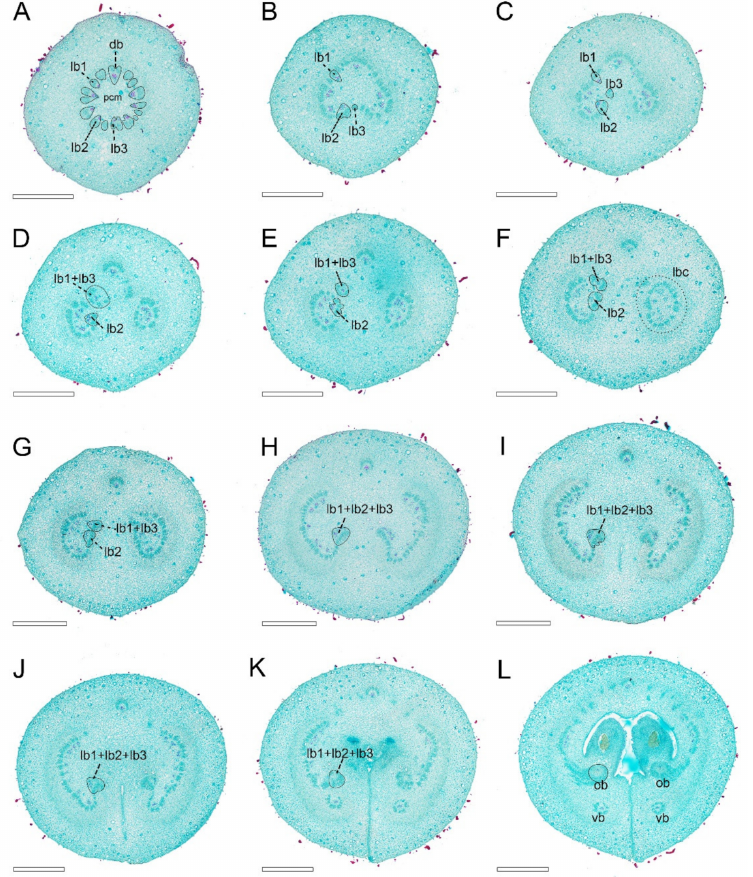
Figure 5. Ascending paraffin transections of mature Anaxagorea luzonensis carpel. Vascular bundles associated with one of the ovule bundles are labeled by solid lines in ( B – L ). ( A ) Carpel base, showing the basal ring. ( B , C ) Basal ring breaks on ventral side. ( D – F ) Ascending carpel stipe sections, showing lateral bundles reconstituted to two sets of ring-arranged lateral bundle complexes (labeled by the dotted line). ( G , H ) Top of carpel stipe, showing “C”-shaped lateral bundle complex. ( I – K ) Below ovary locule, showing formation of ovule bundles. ( L ) Base of ovary locule. Db, dorsal bundle; lb, lateral bundle; lbc, lateral bundle complex; ob, ovule bundle; pcm, parenchyma; vb, ventral bundle. Scale bars = 500 µ